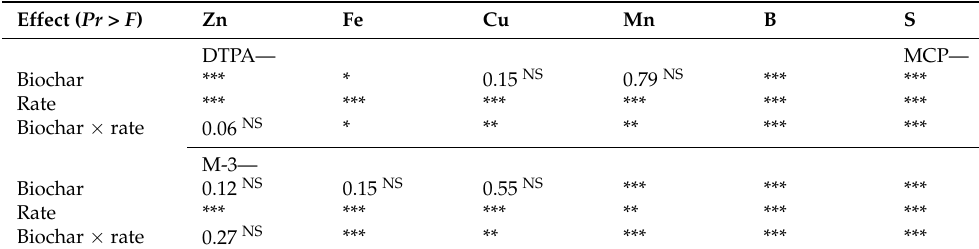
Table 3. Analysis of variance for the effect of the addition of two different feedstock-derived biochars and their application rates on soil nutrients extracted with traditional (DTPA and MCP) and Mehlich-3 solutions.